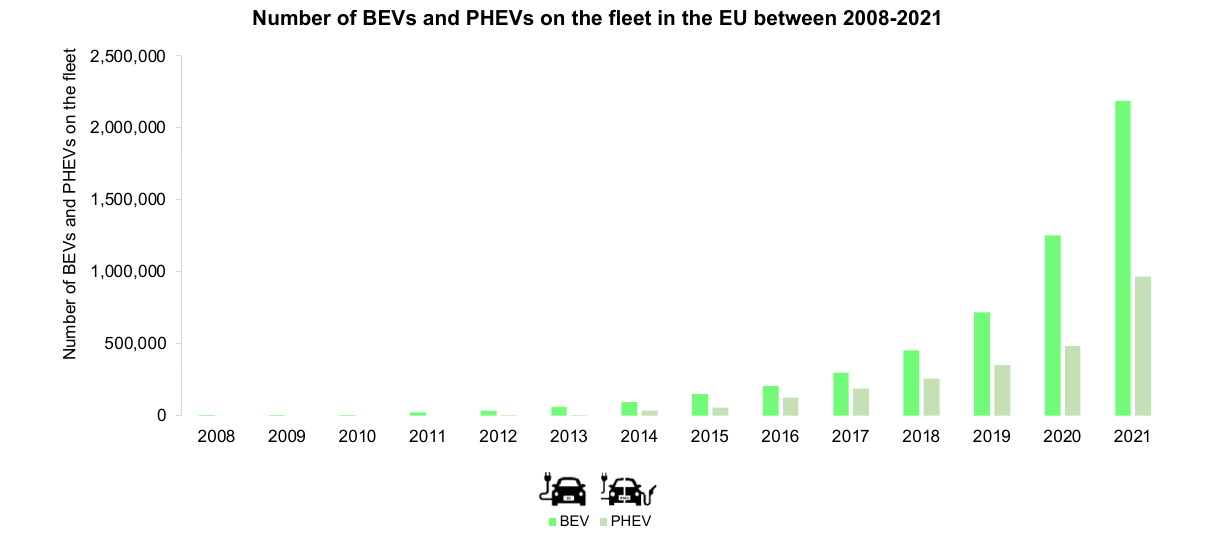
Figure 3. The number of BEVs and PHEVs in the fleet in the EU between 2008 to 2021. This figure was created by the authors with data from the European Alternative Fuels Observatory (EAFO) [11].